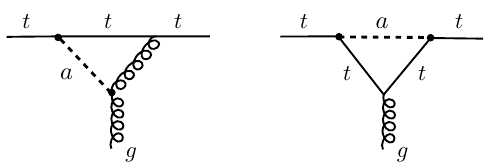
Figure 16 . Diagrams contributing to the chromomagnetic dipole moment of the